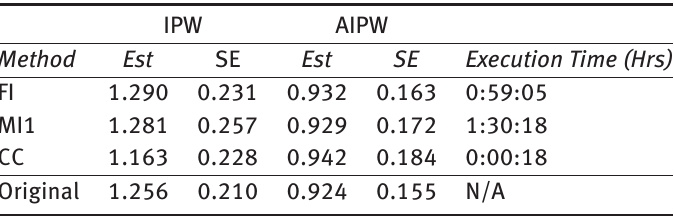
Table 5: Results for estimating the effect of cigarette smoking on blood lead levels: estimate (Est), standard error (SE), and execution time IPW